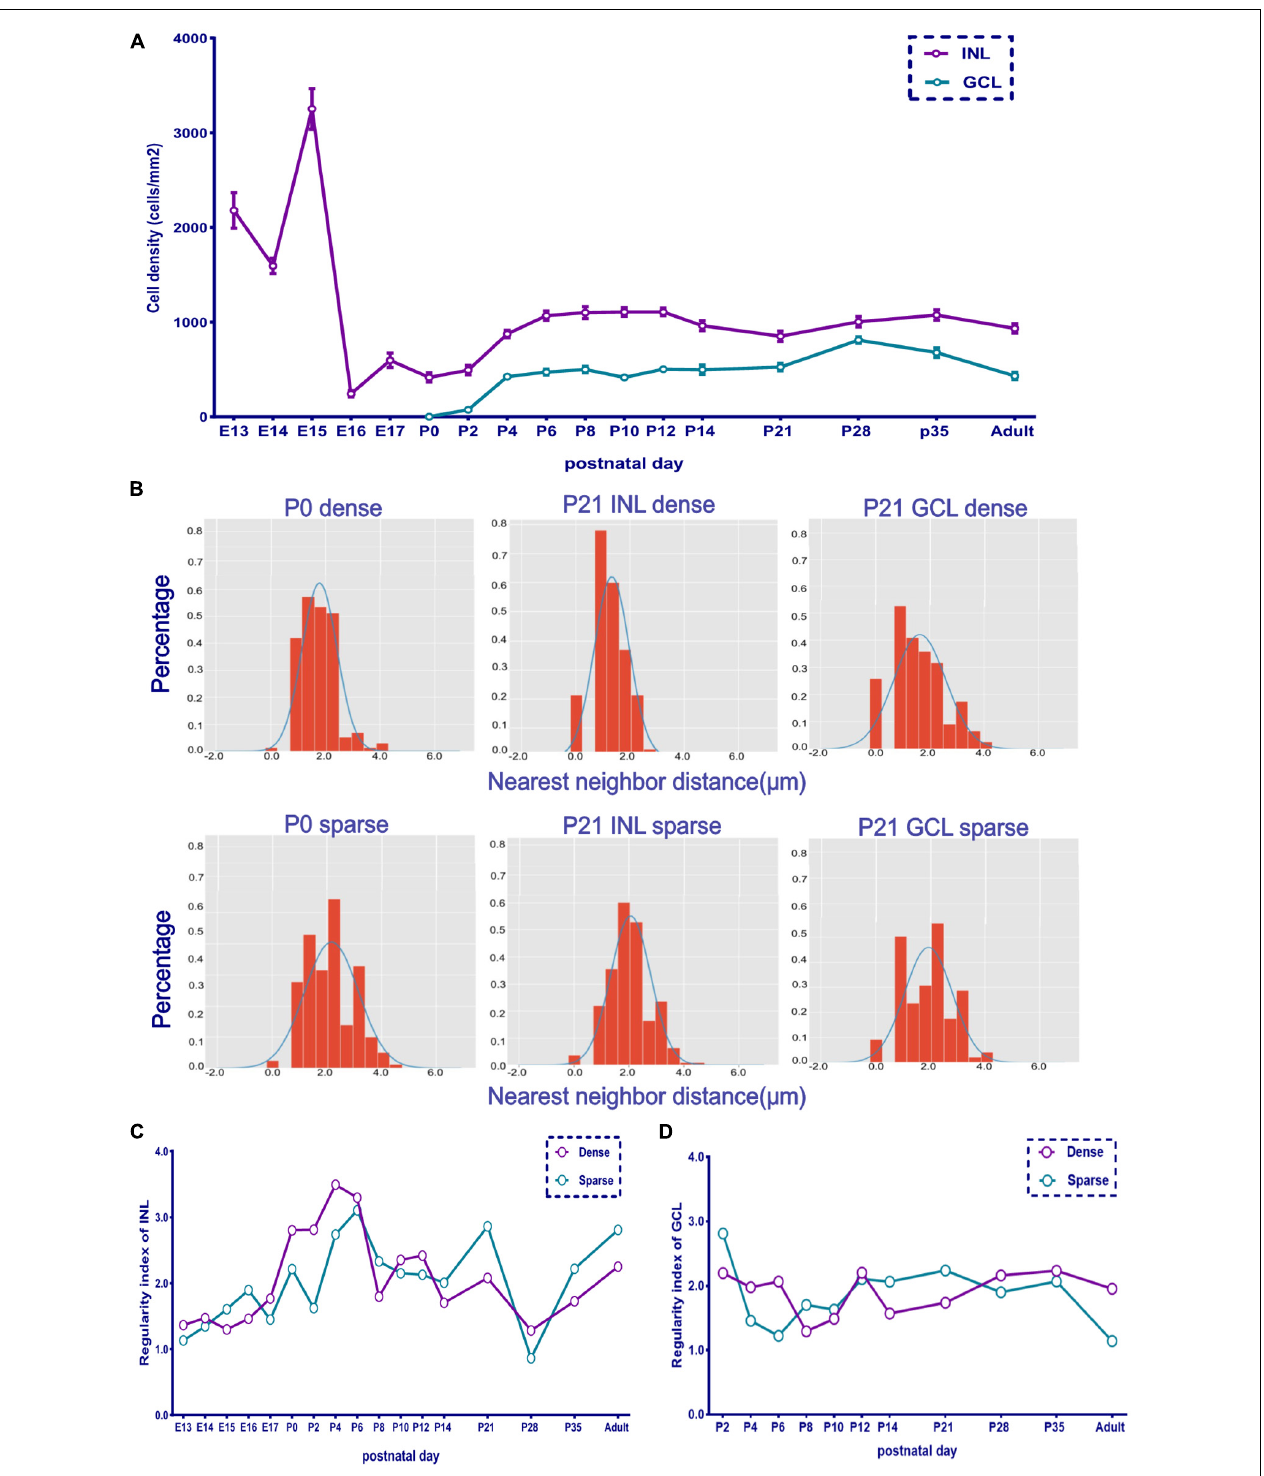
FIGURE 3 | The retina whole-mount distribution of POMC-positive cells was changeable as indicated by the nearest neighbor distances (NND) and regularity. (A) Retina mean POMC-positive cell density of the two layers from E13 to adult. The INL was denser than the GCL, and the GCL/INL ratio was about 0.5 in adults ( n = 12 for each timepoint). (B) NND frequency distribution histogram. The upside shows the dense area, and the downside shows the sparse area. Two images of P0 and four images of P21 are shown. The distribution was not random compared with the Gaussian distribution curve. (C) INL dense and sparse area regularity development curve ( n = 3 for each timepoint). (D) GCL dense and sparse area regularity development curve ( n = 3 for each timepoint).